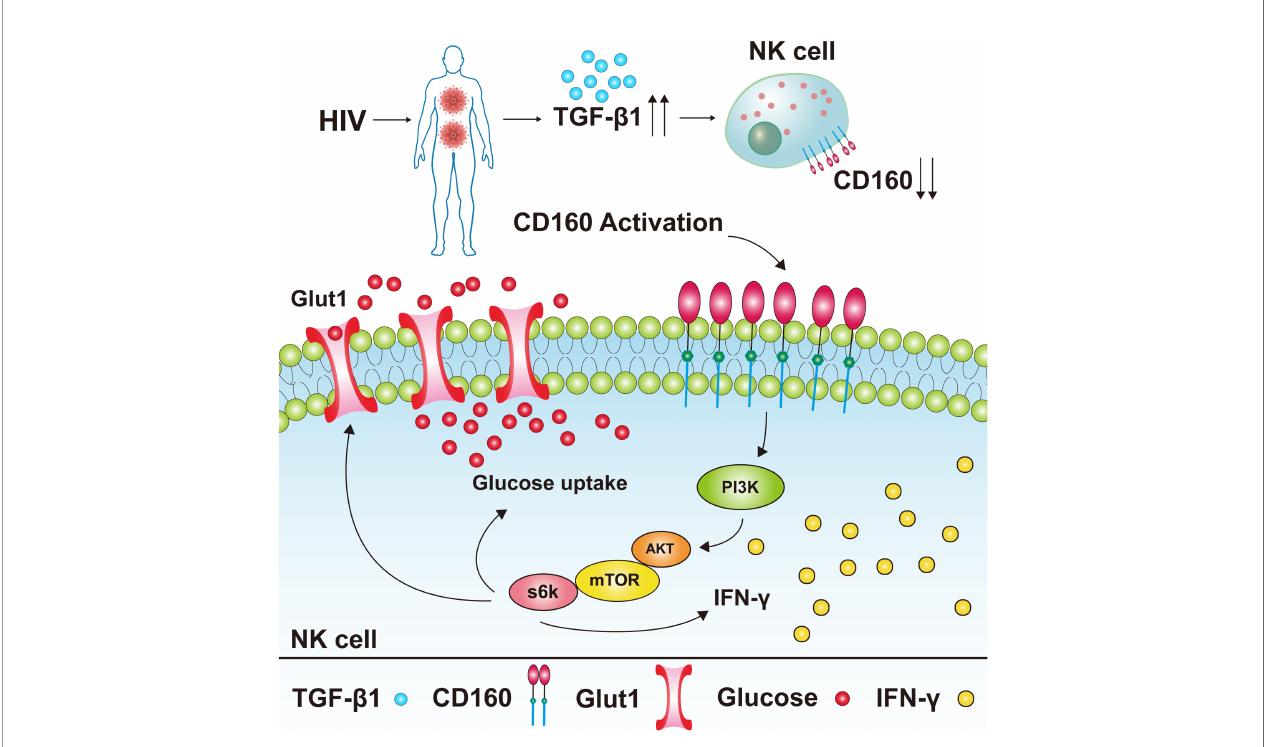
FIGURE 7 | Model of the expression level of CD160 on total NK cells in HIV-infected individuals and its underlying mechanism for NK cell functions. CD160 expression was reduced on total NK cells from HIV-infected individuals, the reason for the reduction of CD160 on total NK cells may be due to the higher plasma levels of TGF- b 1 in HIV-infected individuals. The activation of CD160 can enhance GLUT1 expression and the glucose uptake of NK cells in HIV-infected individuals, and fi nally promotes NK cell functions through the PI3K/AKT/mTOR/s6k signaling